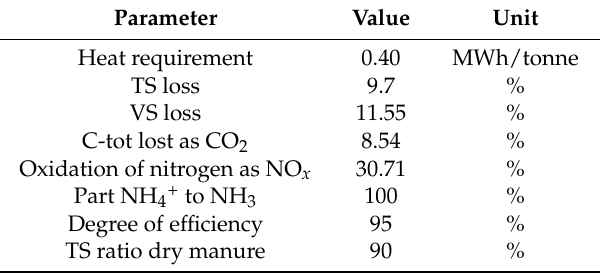
Table A4. Process data on drying of horse manure prior to combustion (%). Data from